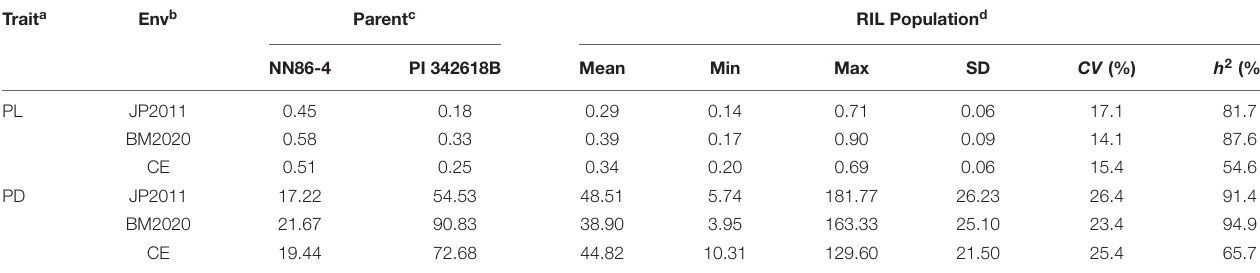
FIGURE 1 | Frequency distribution of pubescence length (PL) and pubescence density (PD) of the RIL population NJRINP and parents. RIL, recombinant inbred line. (A–C) Frequency distribution of PL of JP2011, DT2020, and combined environment, respectively. (D–F) Frequency distribution of PD of JP2011, DT2020, and combined environment, respectively. The black arrow represents the wild soybean PI 342618B and the white arrow represents the cultivar NN 86-4 . TABLE 1 | Descriptive statistics, broad-sense heritability for pubescence length and density in the RIL population NJRINP and parents. Trait